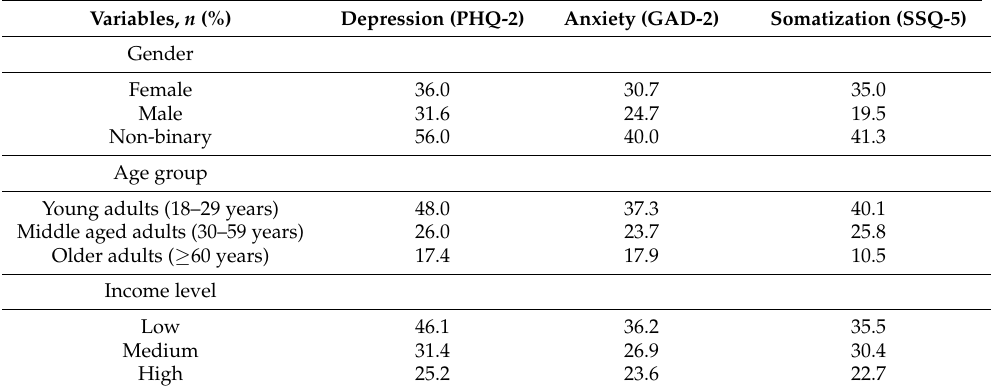
Table 2. Prevalence of mental health risk by social determinants of